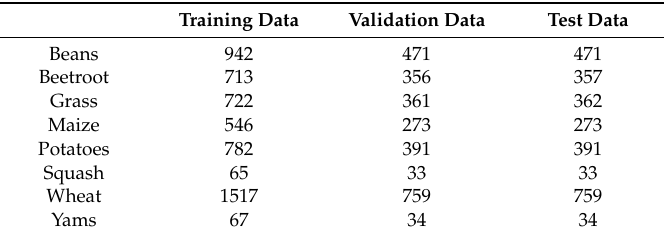
Table 3. Crop type and number of